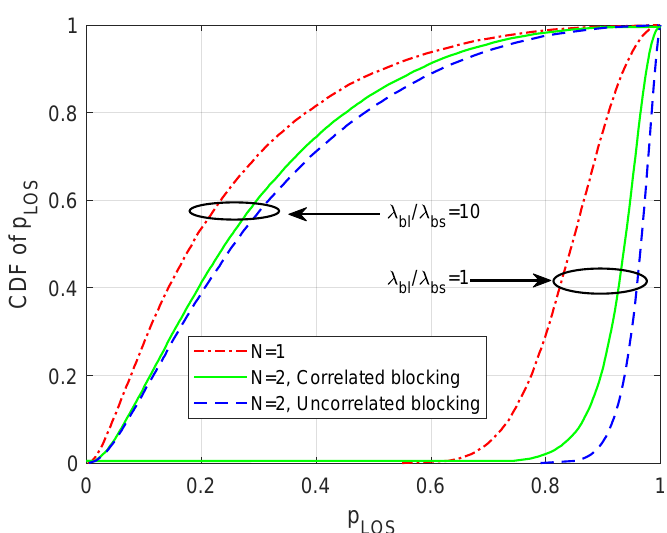
Figure 4. The empirical cumulative distribution function (CDF) of p LOS over 1000 network realizations when N = 1,2, with and without considering blockage correlation at fixed blockage width W = 0.8.